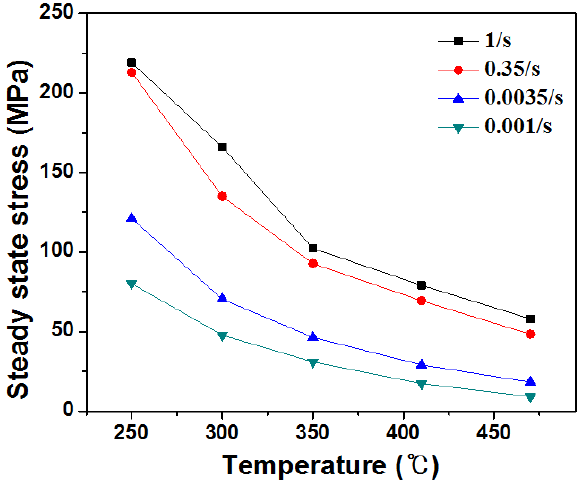
Figure 7. Variation of the steady ‐ state stress with temperature at different strain rates.